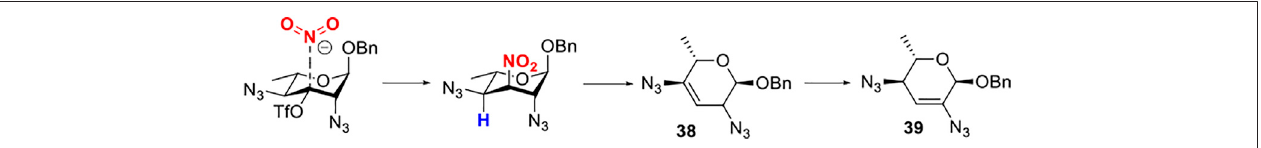
FIGURE 1 | N-attack of nitrite to achieve epimerization of the substrates.